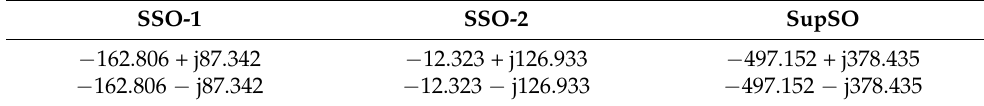
Table 1. Eigenvalues corresponding to oscillation